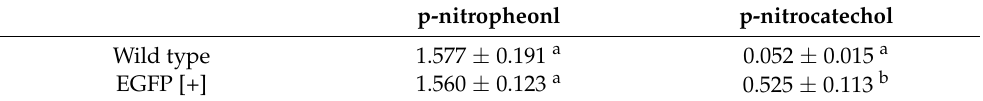
Table 1. Detection of a rat-CYP2E1-specific substrate and its hydroxyl metabolite in rat CYP2E1-TG larvae.